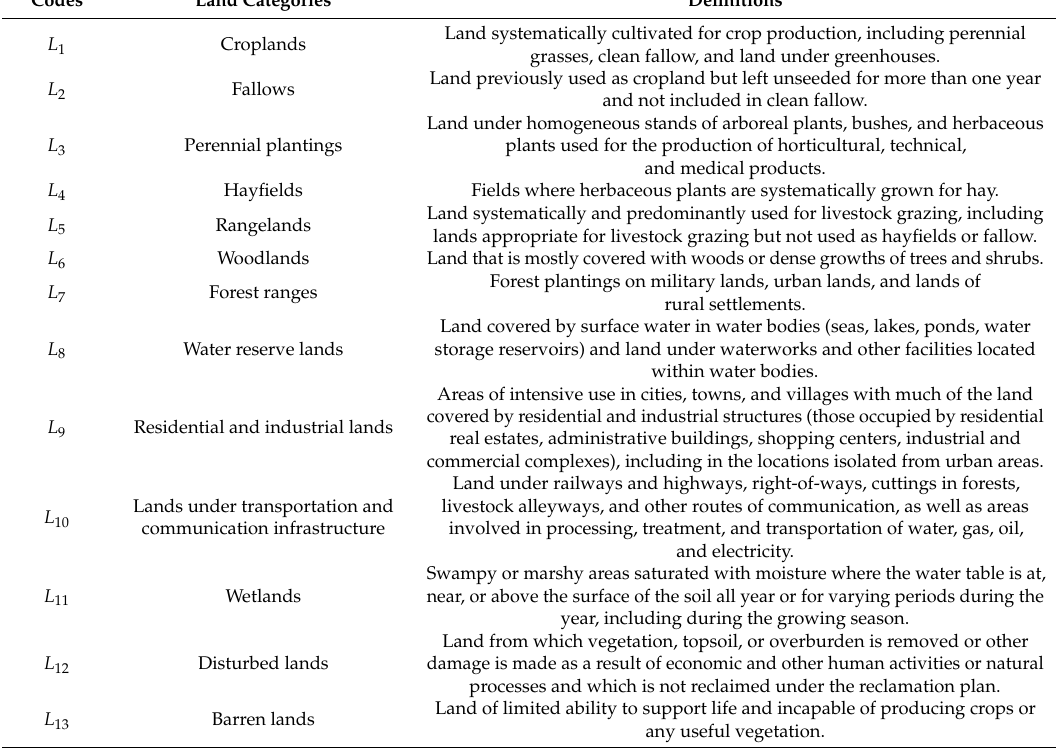
Table 2. Land categories in the